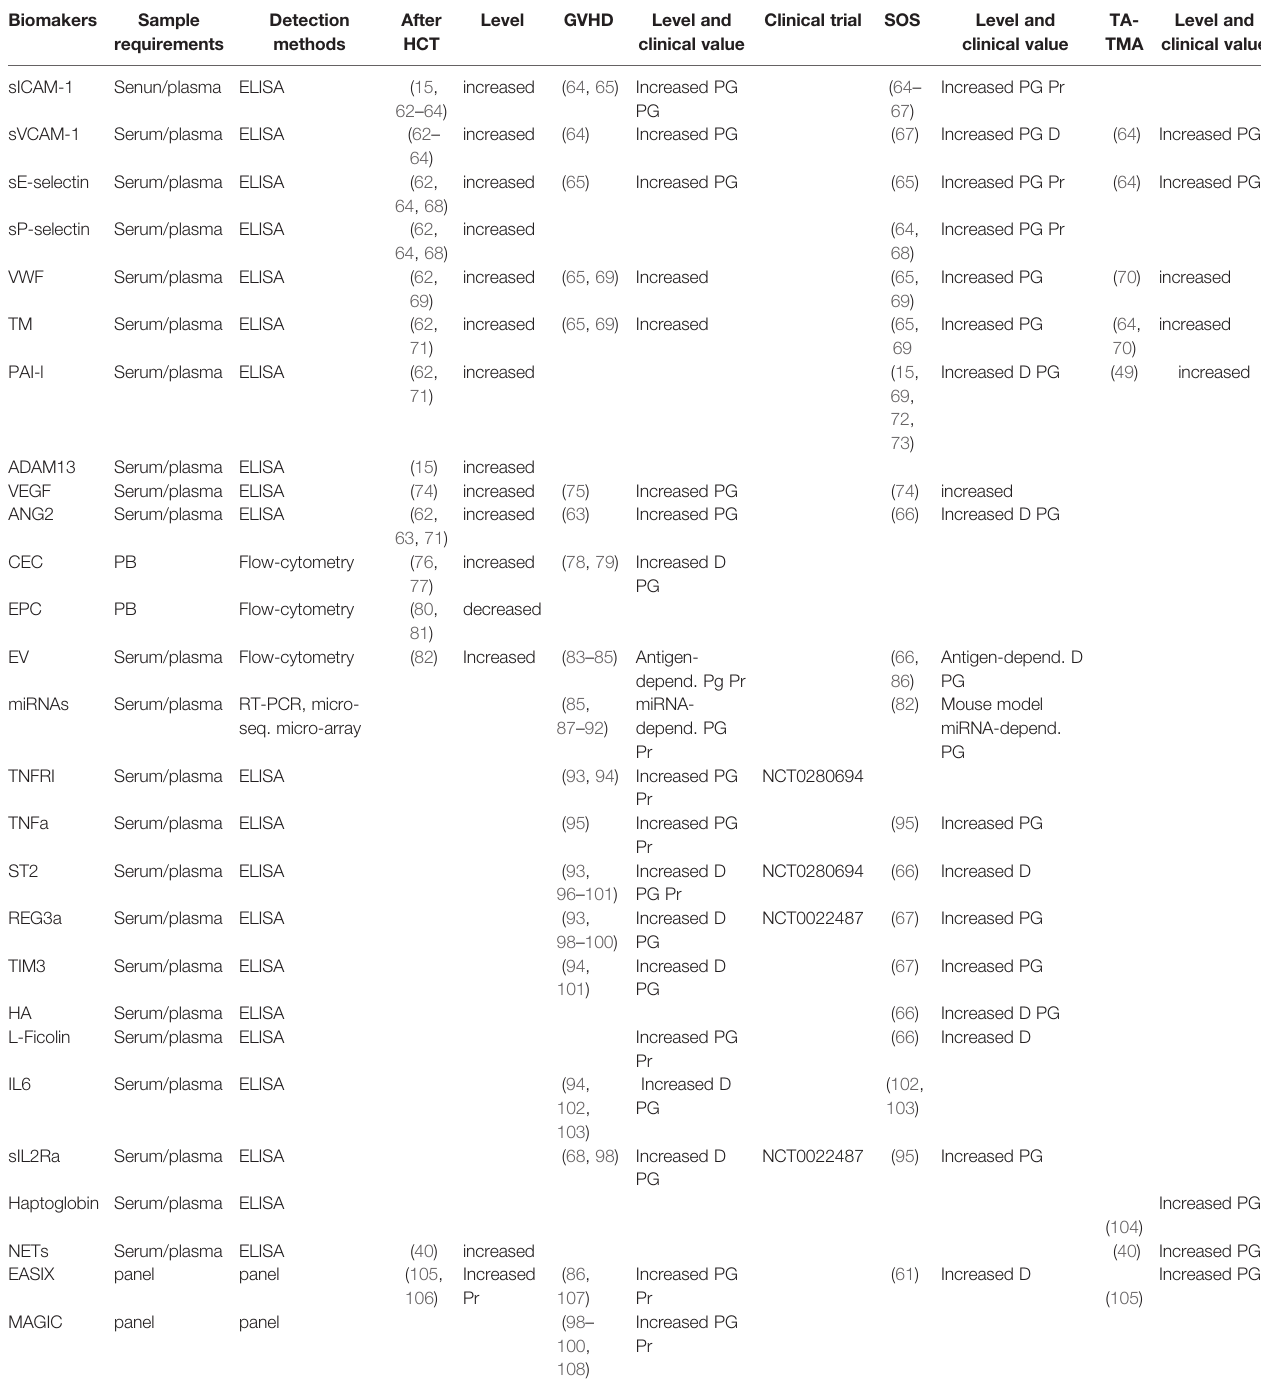
TABLE 1 | Main biomarkers (references) described for endothelium damage, and for GVHD, SOS, and TA-TMA prediction, diagnosis, or risk strati fi cation.